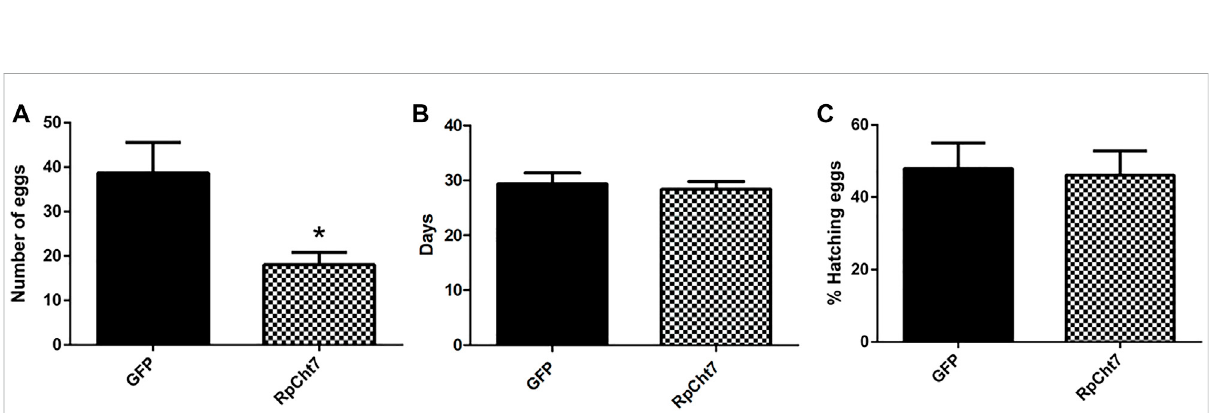
FIGURE 12 (A) Number of eggs per female after injection of dsRNA into fi fth-instar nymphs of R. prolixus . The experiment was performed 5 times with 10 – 15 insects each. * p < 0.0001 (unpaired T-test). (B) Average hatching time of R. prolixus eggs. (C) Hatching percentage of R. prolixus eggs. The experiment was performed 4 times with 200 – 250 eggs each. No signi fi cant differences were found between GFP and RpCht7 groups ( p > 0.05; unpaired